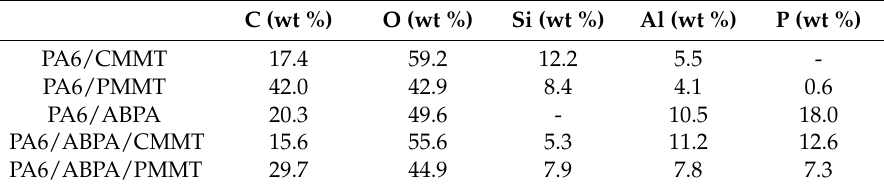
Table 6. Element composition at the outer surface of char layers for different samples.